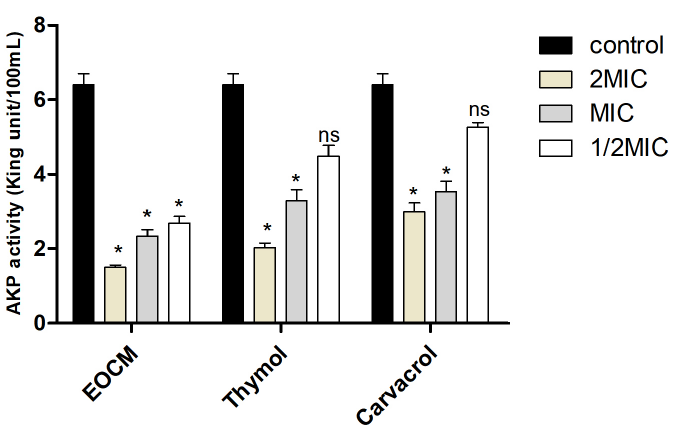
Figure 4. AKP activity from S. aureus treatment with EOCM, thymol and carvacrol. Error bars represent the standard deviations (SD) of the means from three biological replicates ( n = 3) in an individual experiment. *, results were significantly different from those of control by a t test ( p < 0.05). ns, results were no significantly different from those of control by a t test ( p > 0.05).